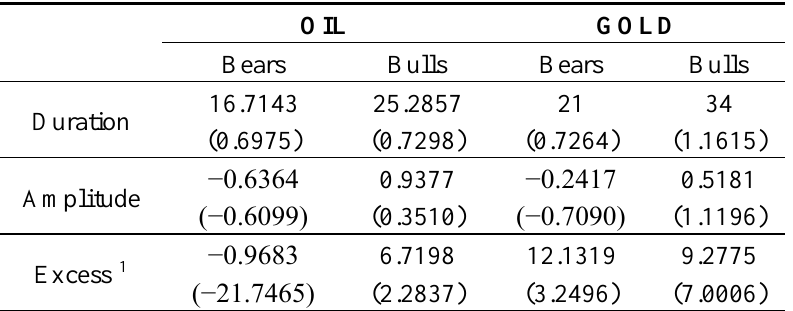
Table 2. Harding and Pagan’s bull and bear market